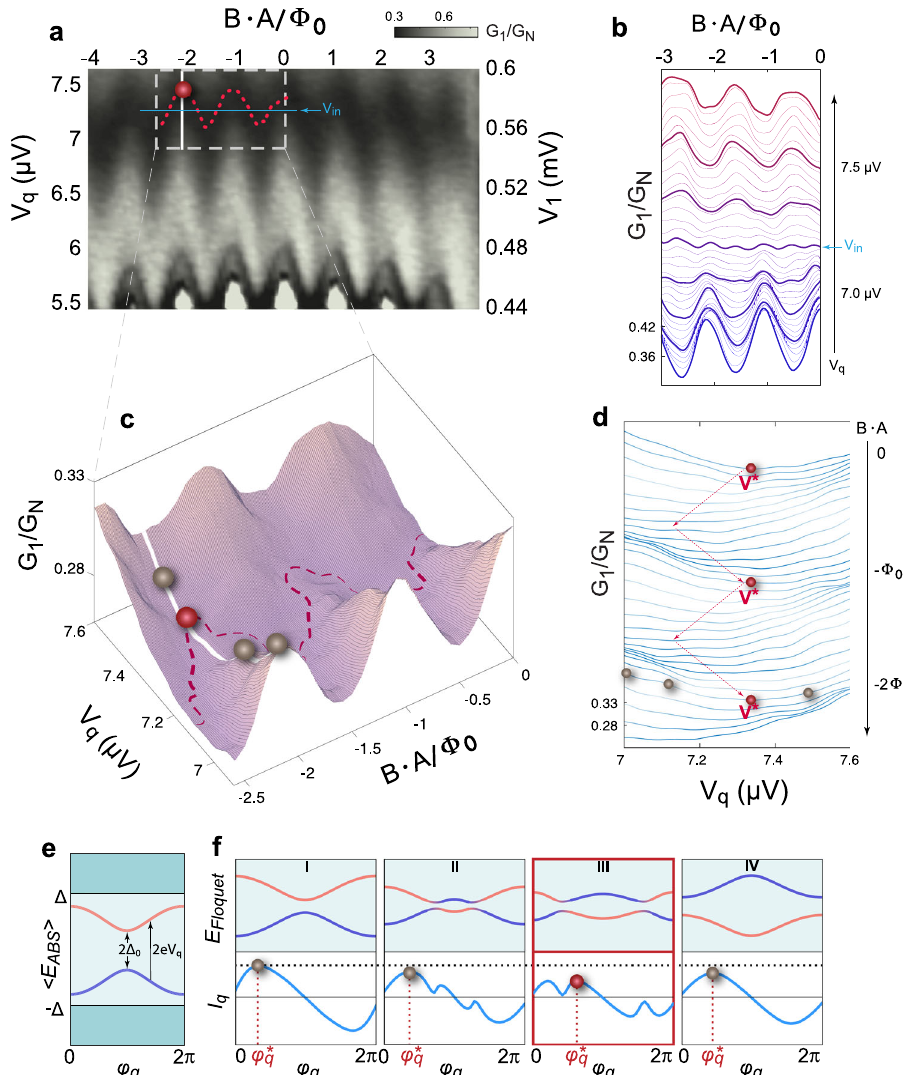
Fig. 4 Quartet conductance and the Floquet spectrum as a function of V q and magnetic fl ux. a Quartet conductance G 1 measured along the quartet line in ; Φ )-plane. Left y -axis is quartet voltage, taken across the junction. Right y -axis is the external applied voltage as shown in Fig. 2 along the yellow dotted ( V q line. The red dashed line traces the minimum conductance for (cid:3) 2 : 5 < (cid:3) Φ = Φ 0 < 0 and the red sphere represents the local minimum at Φ = Φ 0 ¼ (cid:3) 2. b waterfall plot of G 1 ð Φ Þ for V q = 6.9 – 7.6 μ V. It shows clear evolution of G 1 from maxima to minima at integer values of fl ux. At the critical quartet V q (cid:2) V in (cid:5) 7.2 μ V, periodicity is Φ 0 = 2 and for V q > V in , the quartet critical current is «inverted». c Zoom-in surface plot of G 1 ( V q ; Φ ) for (cid:3) 2 : 5 < Φ = Φ 0 < 0. The winding of the red sphere (local minimum) is marked with the red dashed line, matching that in a . The gray spheres represent quartet conductance at different values of V q . d waterfall plot of G 1 ( V q ) for Φ = Φ 0 = − 2~ 0. The local minimum V (cid:6) presents a zig-zag pattern as fl ux is tuned. e When the quartet voltage V q is in the adiabatic limit, the adiabatic Andreev levels < E ABS > depend only on one phase variable, the quartet phase φ . The minimum difference q between the two levels is the Andreev gap Δ 0 and a fi nite V q creates resonant coupling between the two levels. f upper panel shows the energy of the Floquet states as a function of the quartet phase φ at different values of V q . The corresponding quartet current I q carried by these Floquet states is shown q Þ , matching the ones in c . In (III), the red sphere in the lower panel. The gray and red spheres mark the critical values of the quartet current I qc ¼ I q ð φ (cid:6) q denotes V q = V (cid:6) when I qc reaches a local minimum, re fl ecting an avoided crossing in the Floquet